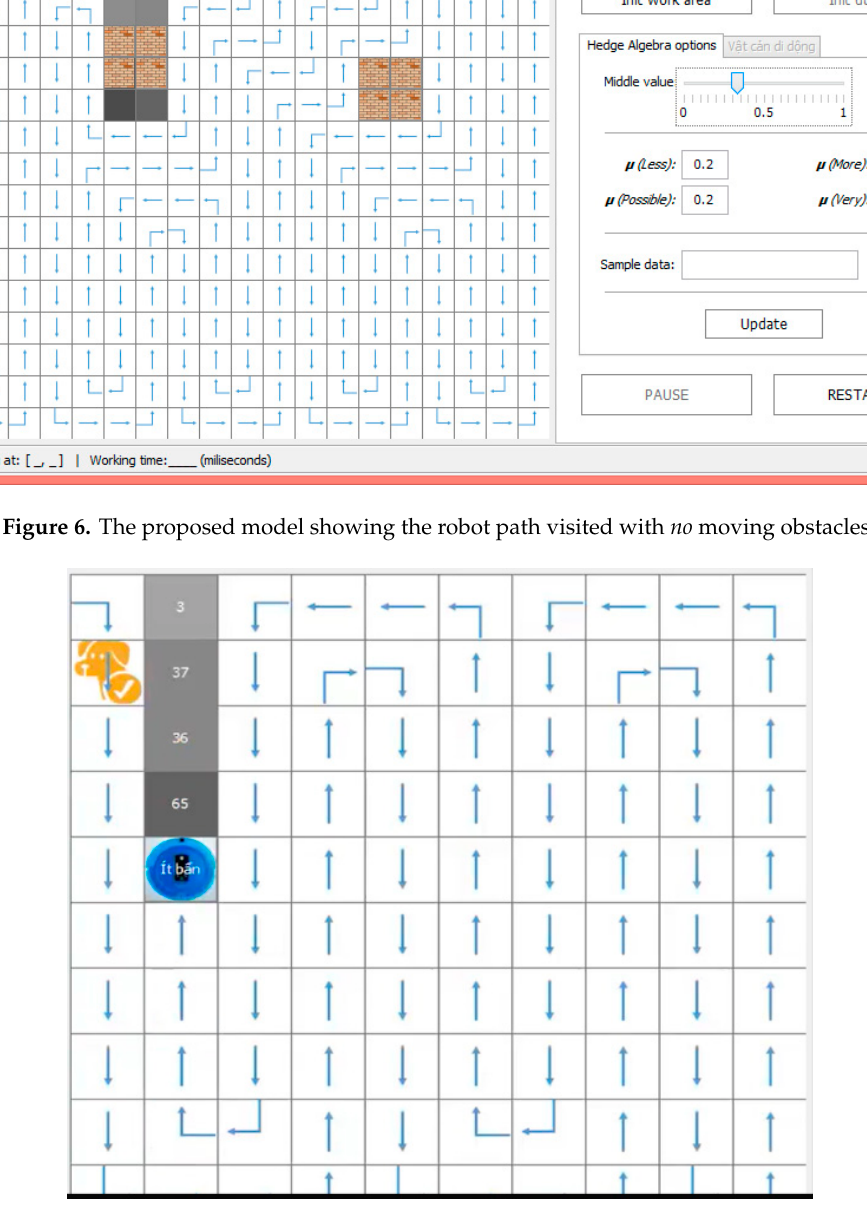
Figure 7. The proposed model showing the robot path visited with moving obstacles.